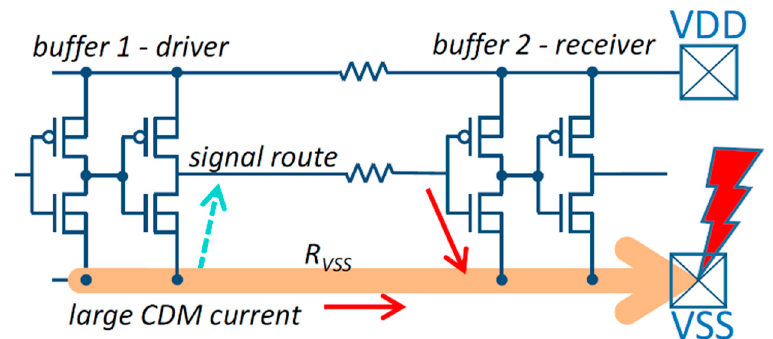
Figure 2. Long wire effect with CDM stress [10] (Copyright 2021 with permission from author; li ‐ cense number 5004691247069); if there is a source of CDM stress and it comes across a long wire (that forms a large wire resistance), the damage can be catastrophic.